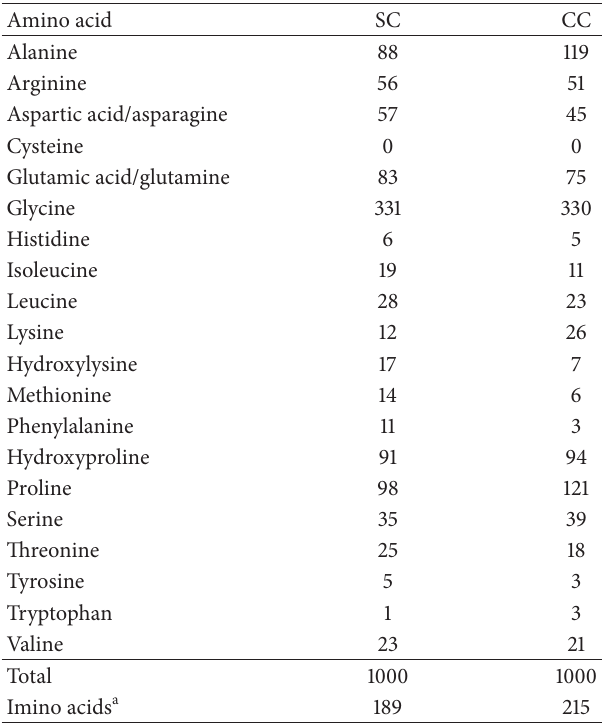
Table 2: Amino acid composition of collagen from the skin of splendid squid (SC) and type I collagen from calf skin